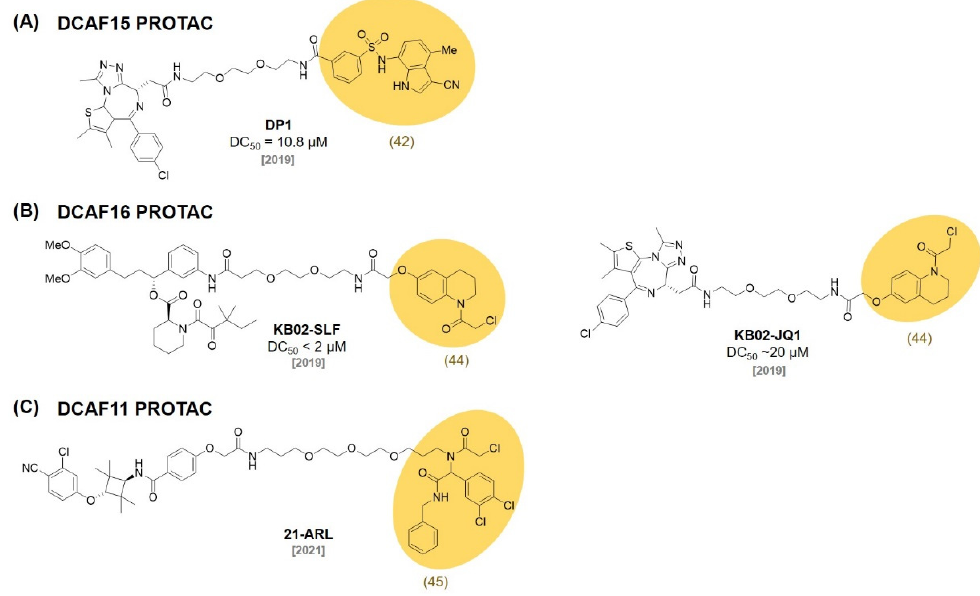
Figure 13. Recently developed PROTACs utilizing various DCAF ligands.